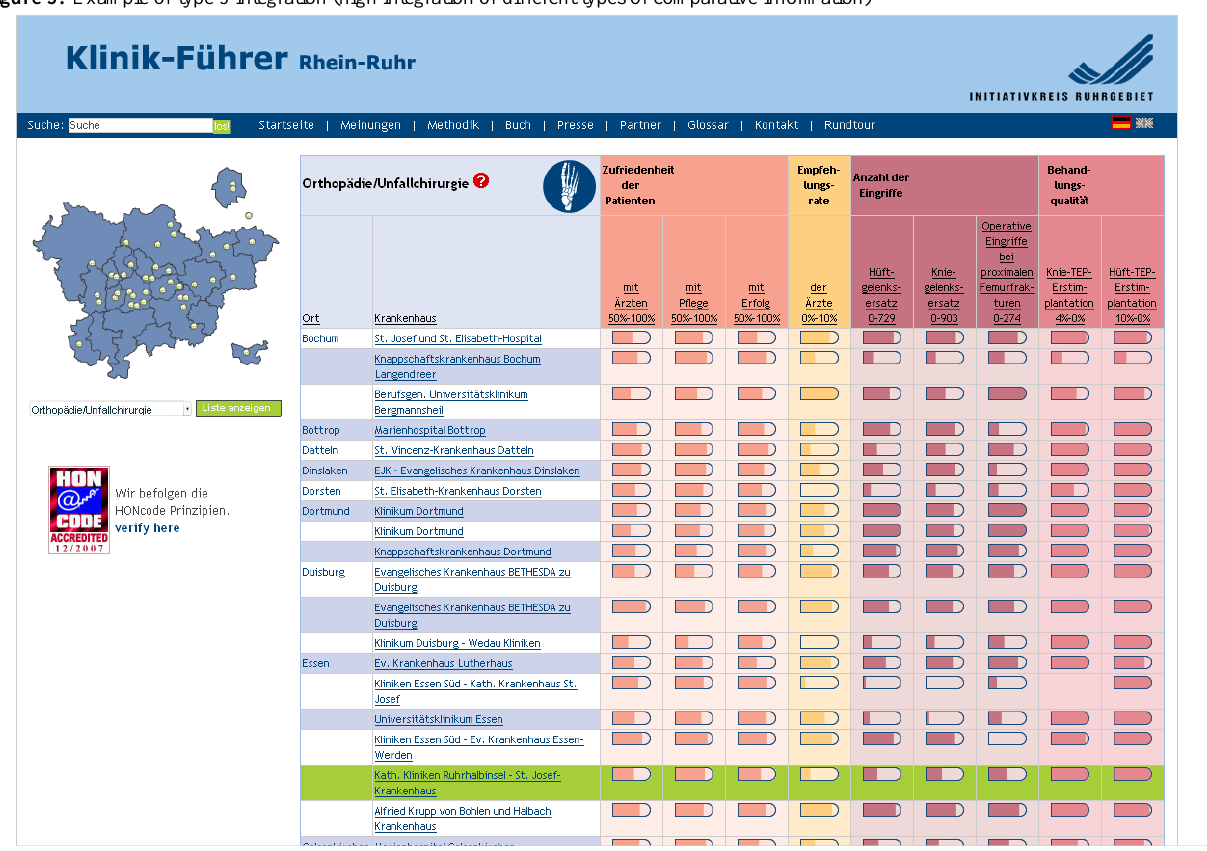
Figure 5. Example of type 3 integration (high integration of different types of comparative